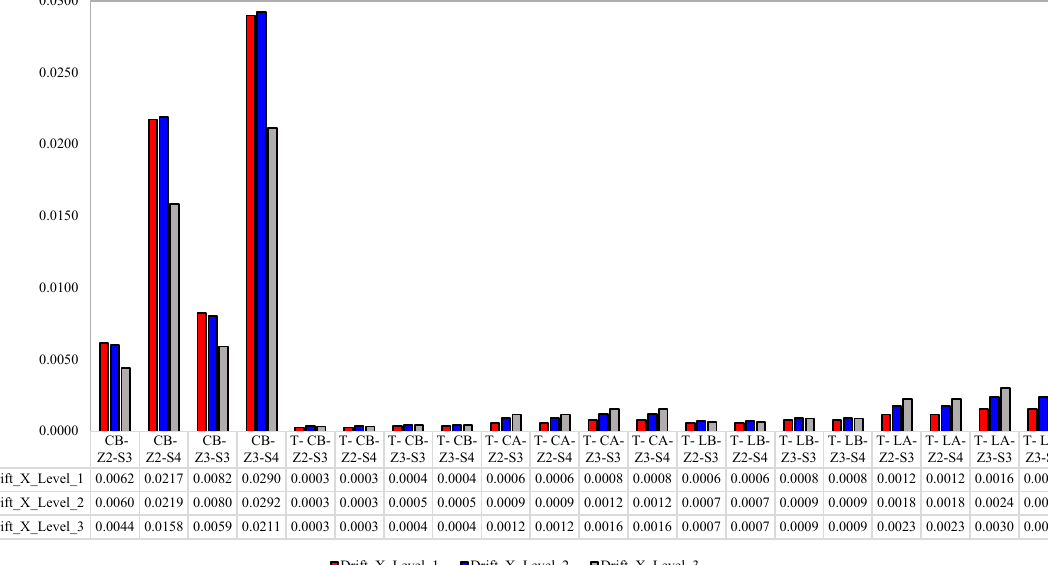
Figure 6. Drift by level in down-aisle direction.